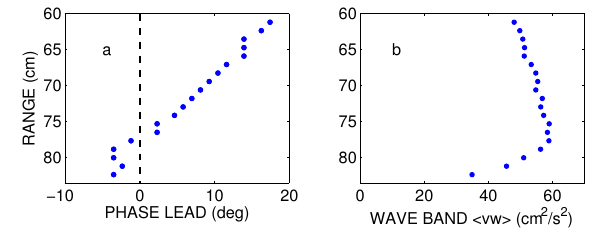
Figure 12. Vertical structure of the phase and magnitude of the wave-band cross-shore shear stress. YD130.64.